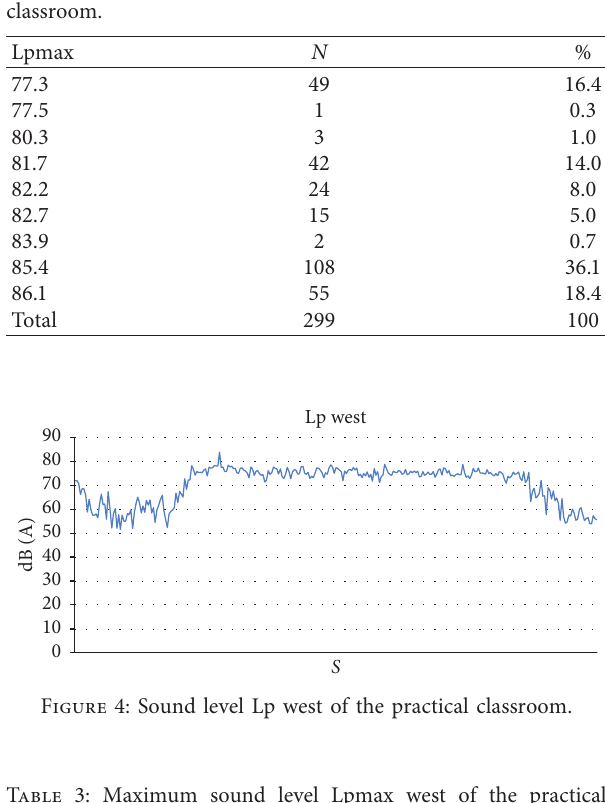
Table 2: Maximum sound level Lpmax east of the practical